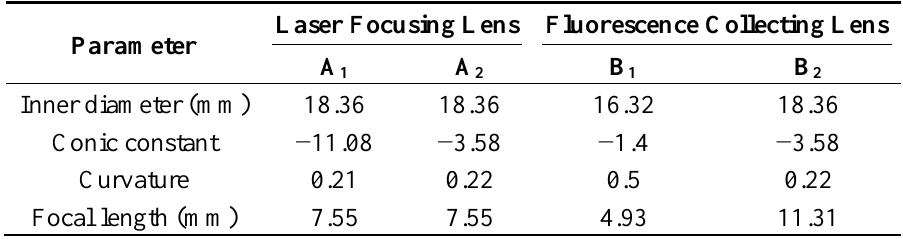
Table 1. Parameters of the laser focusing lens and fluorescence collecting lens.